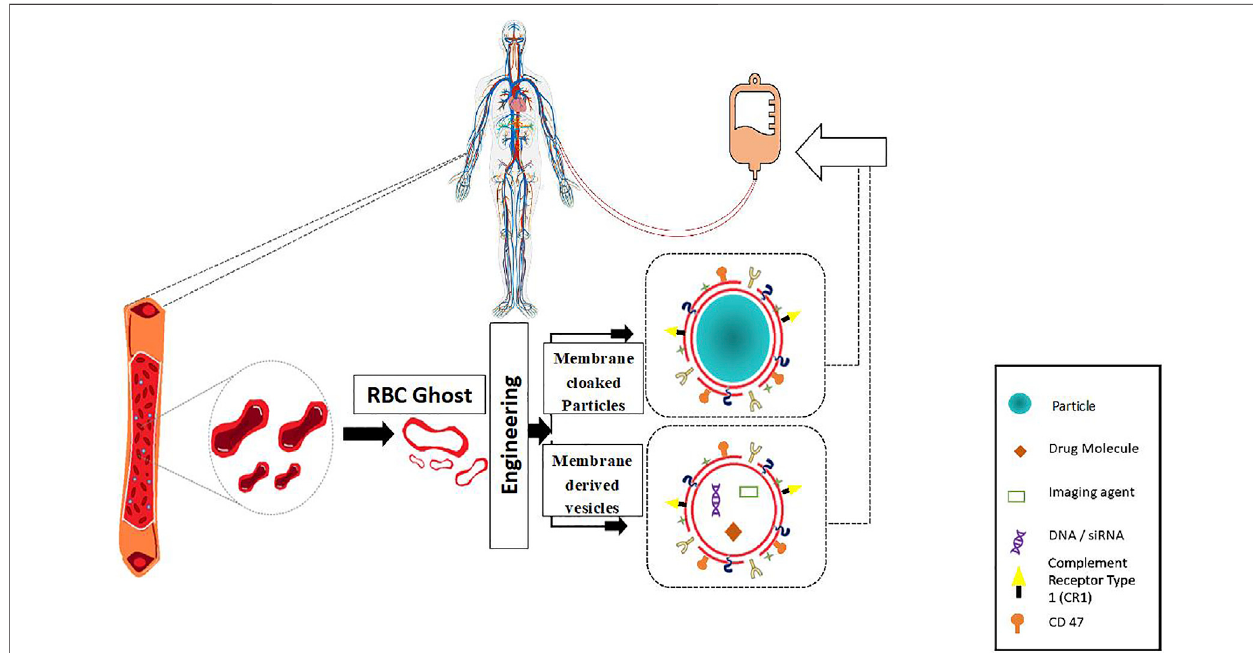
FIGURE 2 | Overview of RBC-based drug delivery